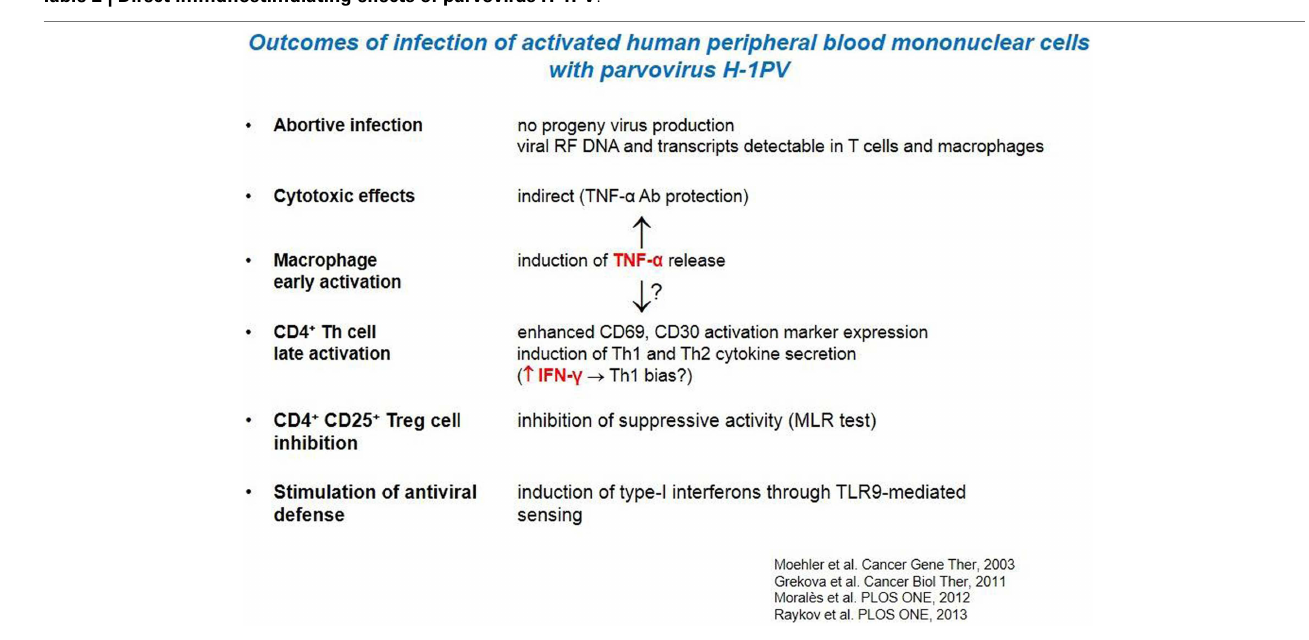
Table 2 | Direct immunostimulating effects of parvovirus H-1PV